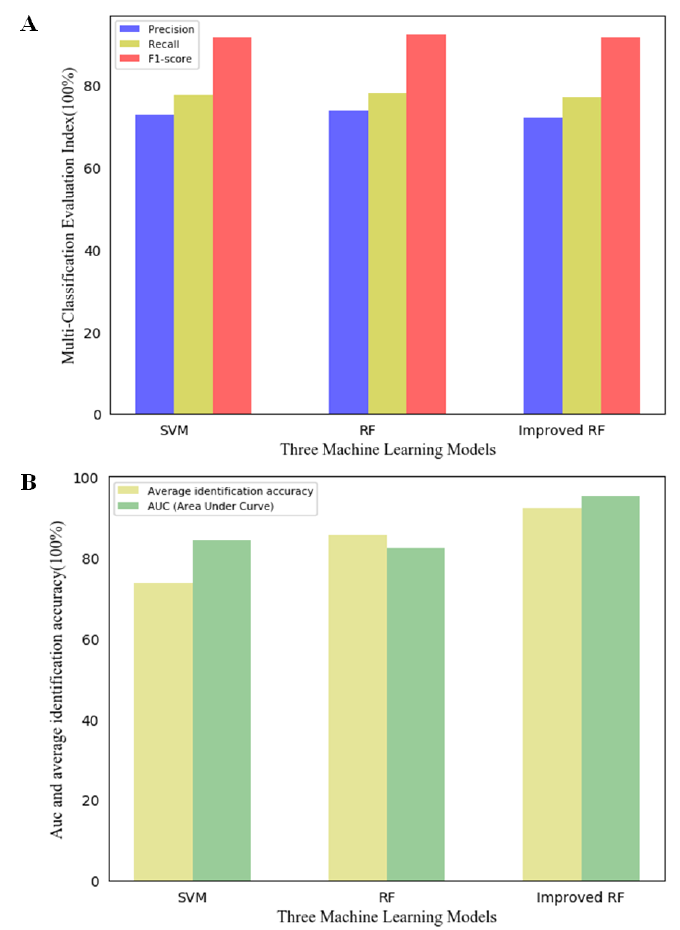
Figure 12. The difference in F1 , Pre and Rec ( A ) and comparison of AUC and Average identification accuracy ( B ). The Roc curve in Figure 13 describes the identification ability of each model. If each curve is closer to the left, the larger the area enclosed by the horizontal and vertical coor- dinates is, and the stronger the identification ability of the model is.